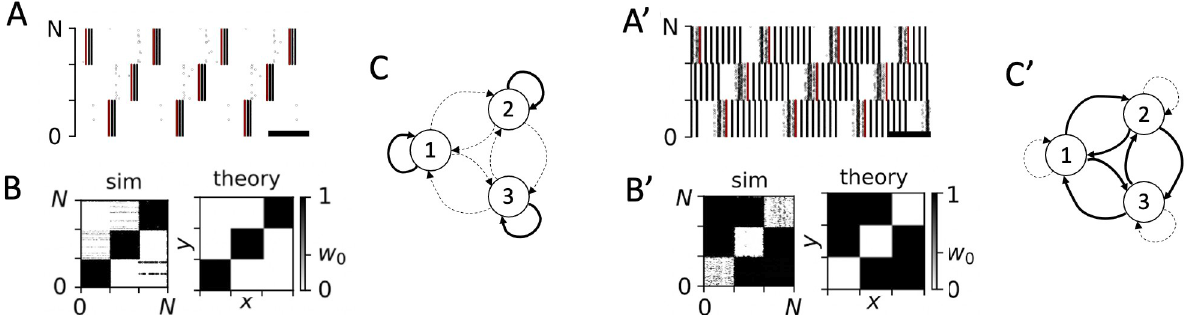
Fig 10. PMCS can be employed to modulate intra- and inter-population synapses in opposite ways. A: Raster plot of simulated spiking activity for PMCS with burst stimuli with high intraburst frequency. B: Snapshots of simulated synaptic weight matrix after 1000 sec of stimulation (sim) and the corresponding theoretical prediction obtained from Eq 1 (theory). C: Schematic of stimulation-induced network structure (see caption of Fig 9 for symbols). A’-C’: Same as A-C but for burst stimuli with low intraburst frequency. Parameters: A stim = 0.8, f = 5 Hz, and d e = 1 (all panels). In panels A-C, we used an intraburst frequency of 120 Hz, three pulses per burst, and Δ α 1/2 = 0.33 (A-C), In panels A’-C’, we used 60 Hz, eight pulses per burst, and Δ α 1/2 = 0.31 (A’-C’).